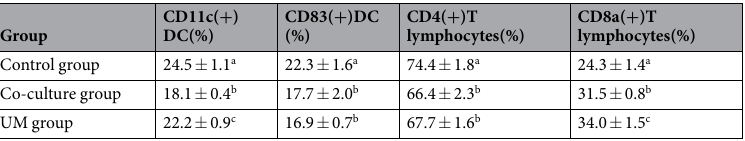
Table 3. The proportion of CD11c( + ),CD83( + ) DC and CD4( + ), CD8a( + ) T lymphocytes examined by flow cytometry (mean ± SD). a Compared with co-culture group and UM group, b compared with control group and UM group, c compared with control group and co-culture group (P <